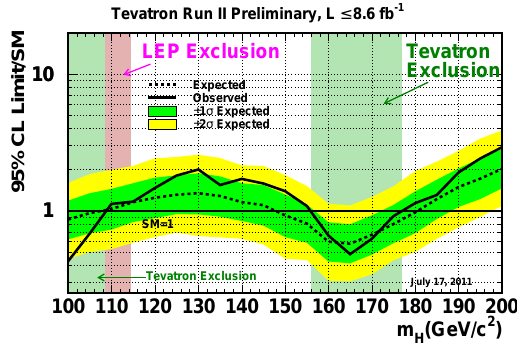
Fig. 7. The combined observed (solid black lines) and expected (dashed black lines) 95% C.L. upper limit on σ ( p ¯ p B ( H W + W − ) are shown in the 4th generation model as a func- → tion of the Higgs boson